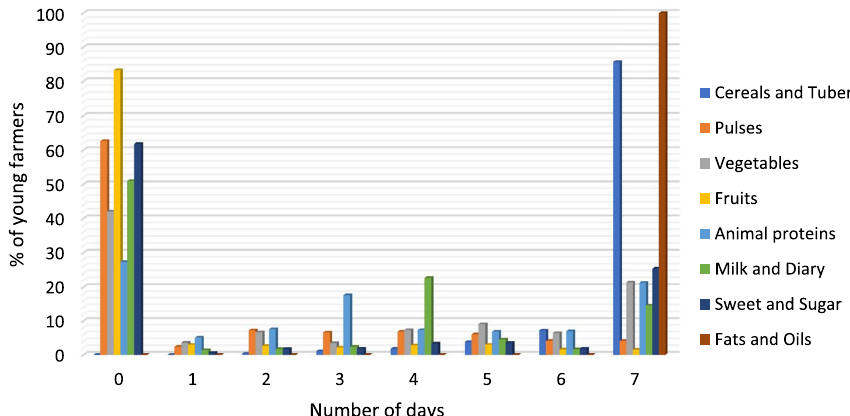
Fig. 1 Youth consumption of different food groups over a 7-days recall